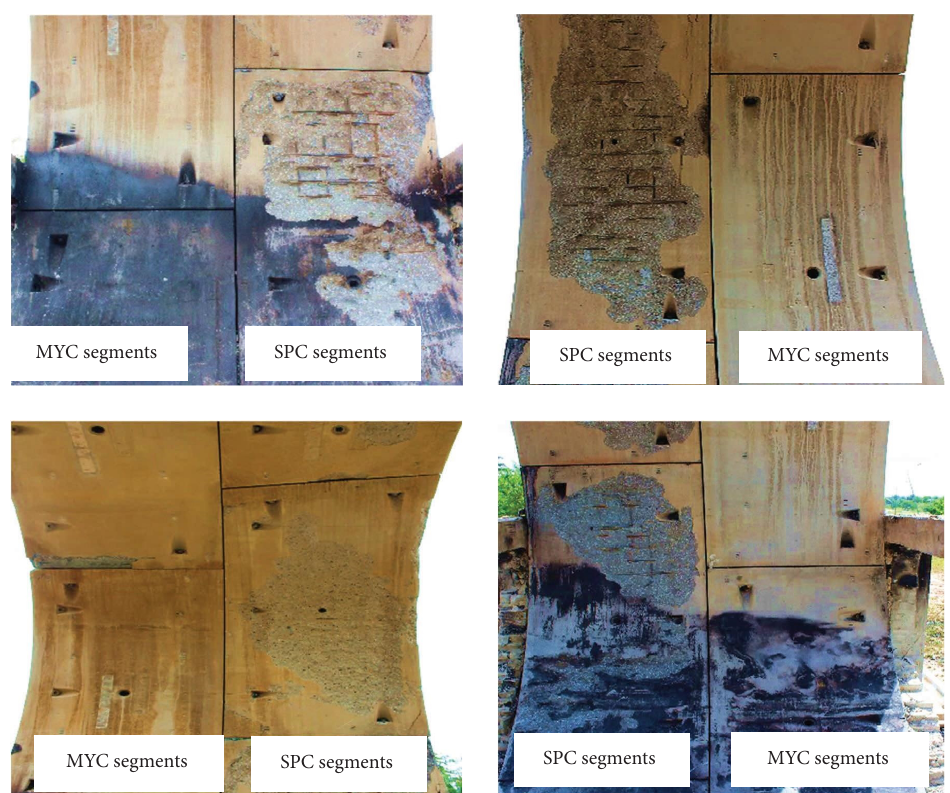
Figure 9: Spalling at diferent locations of SPC and MYC segments.